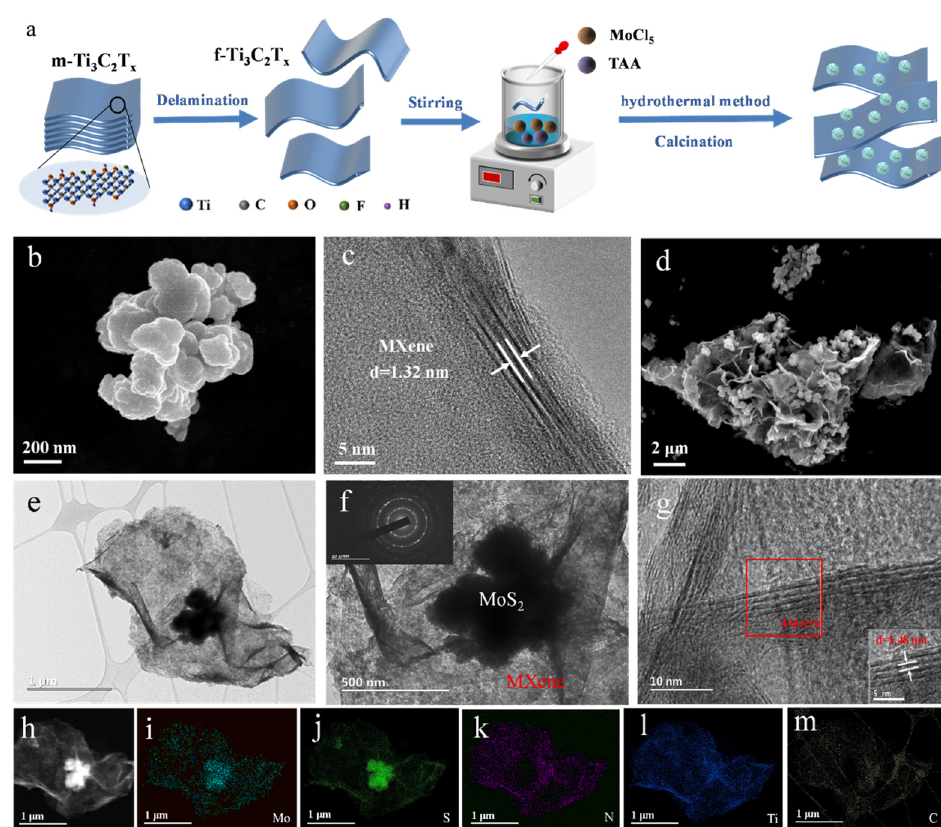
Figure 1. ( a ) Schematic diagram of the synthesis process of MoS 2 /MXene. ( b ) SEM images of MoS 2 ; ( c ) HRTEM images of MXene; ( d ) SEM images of MoS 2 /MXene; ( e–f ) TEM images of MoS 2 /MXene, where inset ( f ) is SEAD pattern of MoS 2 /MXene; ( g ) HRTEM images of MXene in the MoS 2 /MXene composite, where inset is its HRTEM image at higher magnification; ( h – m ) elemental mapping of MoS 2 /MXene.